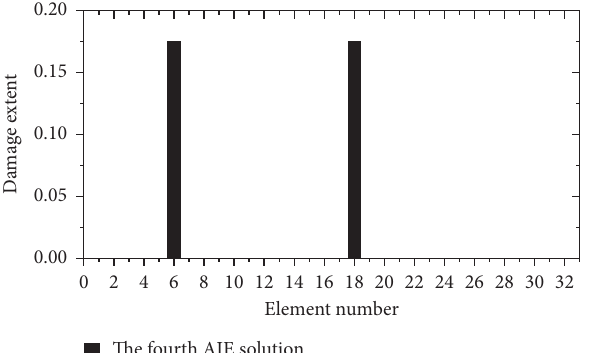
Figure 10: Damage assessment result by the fourth AIE when elements 6 and 18 are